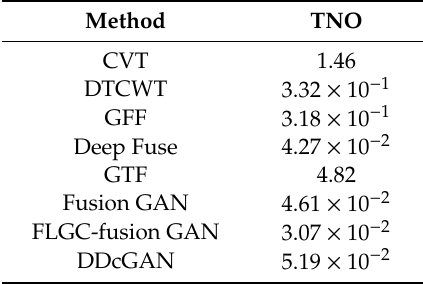
Table 8. Run time comparison of six methods on the TNO datasets. The fusion GAN, FLGC-fusion GAN, and DDcGAN are performed on graphics processing unit (GPU), while others are performed on the central processing unit (CPU). Each value denotes the mean of the run time of a specific method on a dataset (unit: